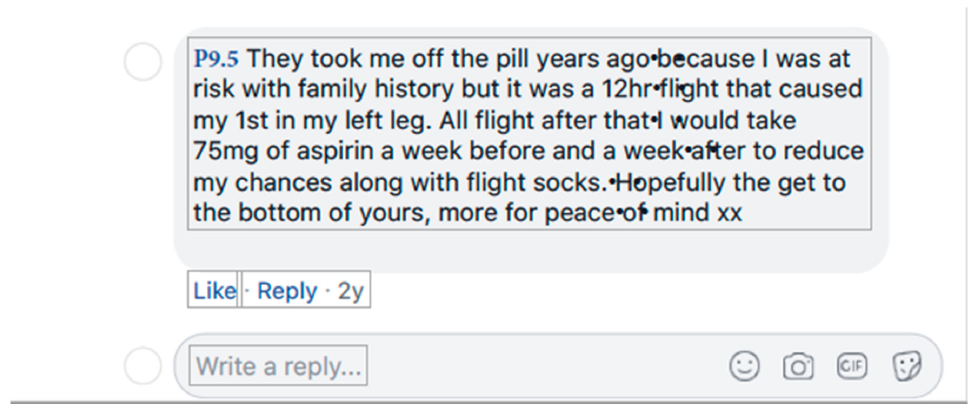
Figure A2. Responses to Figure A2.